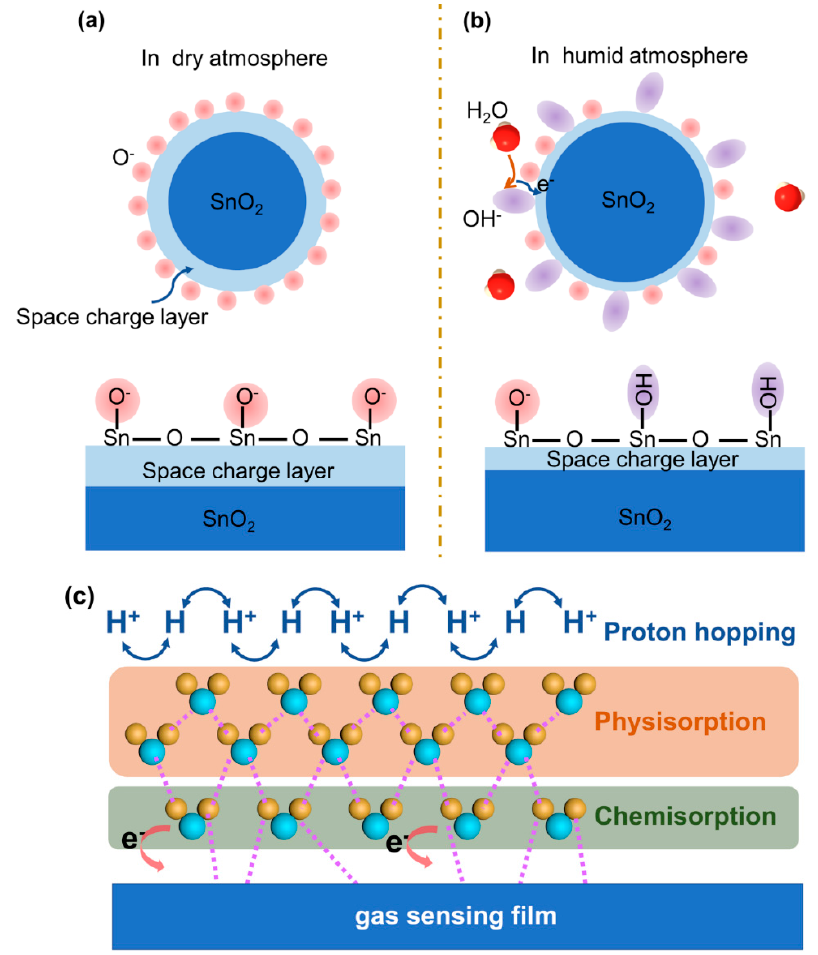
Figure 1. Schematic diagram of gas − sensing model for SnO 2 in ( a ) dry atmosphere and ( b ) humid atmosphere. ( c ) Schematic illustration of chemisorption and physisorption of water molecules in high-humidity conditions.